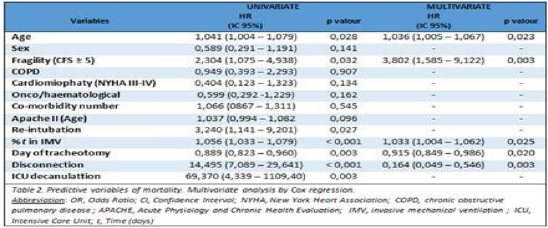
Table 2 (abstract 000912). See text for